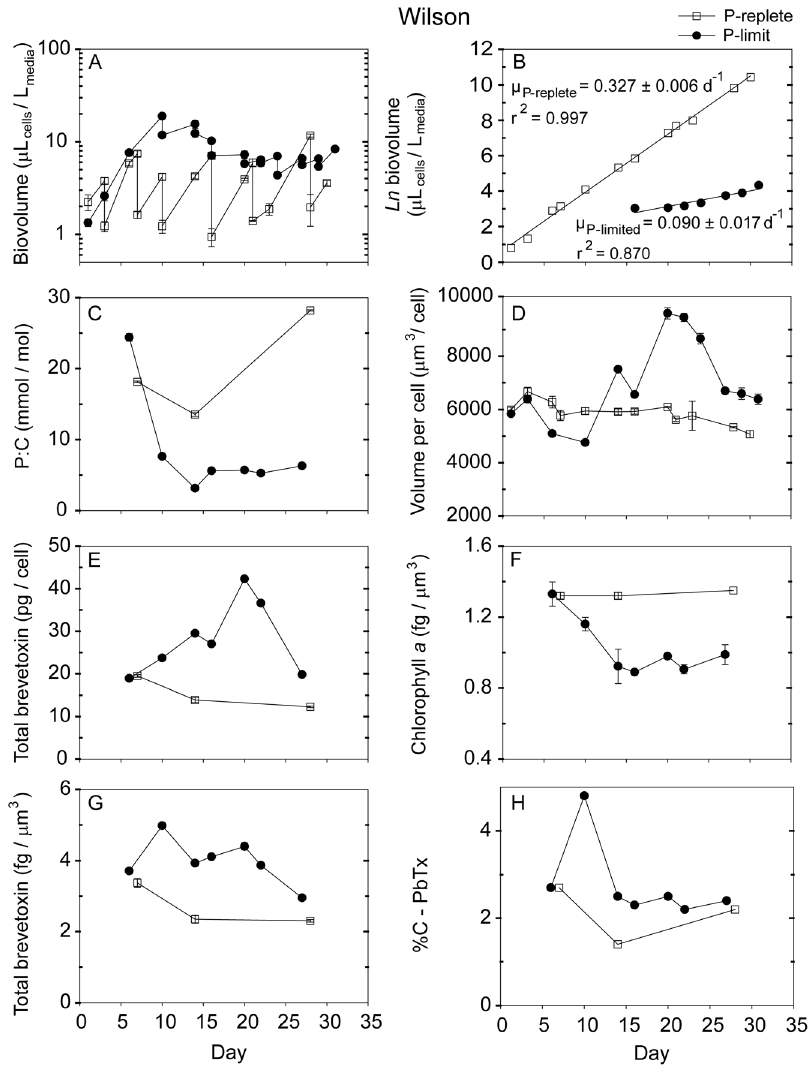
Figure 2. Time-dependent results from semi-continuous batch cultures of Kareniabrevis strain Wilson grown at nutrient-replete rates in high-P media (open squares) and grown into P-limitation in low-P media (filled circles). (A) Biovolume ( m L cells /L media ) plotted on a log scale vs. time, (B) Natural logarithm (ln) biovolume vs. time, correcting for culture dilution [39], (C) Cellular P:C ratios (mmol/mol), (D) Mean volume per cell ( m m 3 /cell), (E) Total brevetoxins per cell (pg/cell), (F) Chlorophyll a normalized to cell volume (fg/ m m 3 ), (G) Total brevetoxins normalized to cell volume (fg/ m m 3 ), (H) Percent of cellular carbon associated with brevetoxins (%C-PbTx). Error bars represent the standard deviation of triplicate measurements, except those normalized to carbon, where the cellular C was measured only in